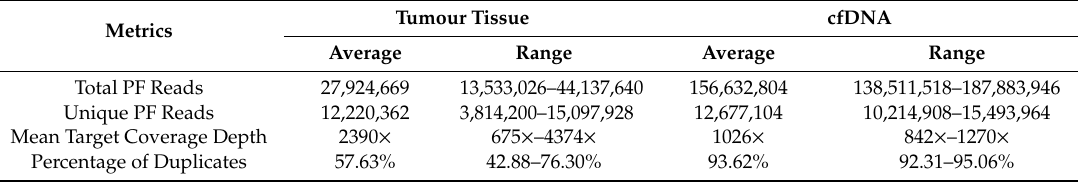
Table 1. Sample sequencing